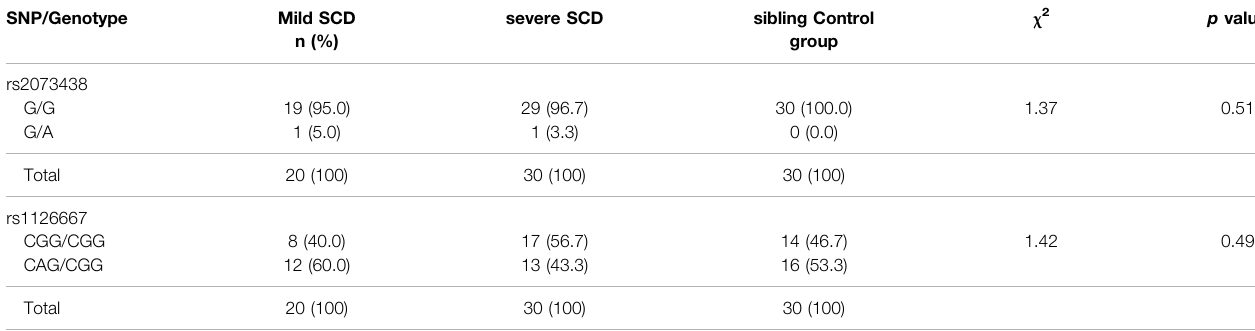
TABLE 5 | ALOX12 SNP genotypes in relation to the severity of sickle cell disease.